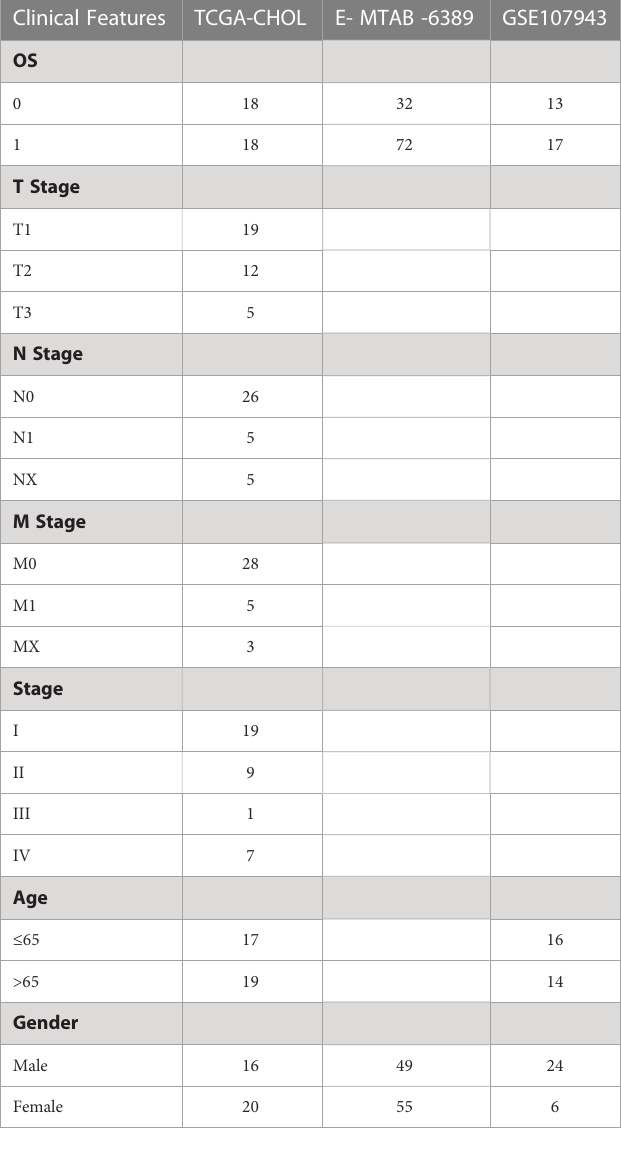
TABLE 1 Sample information of three